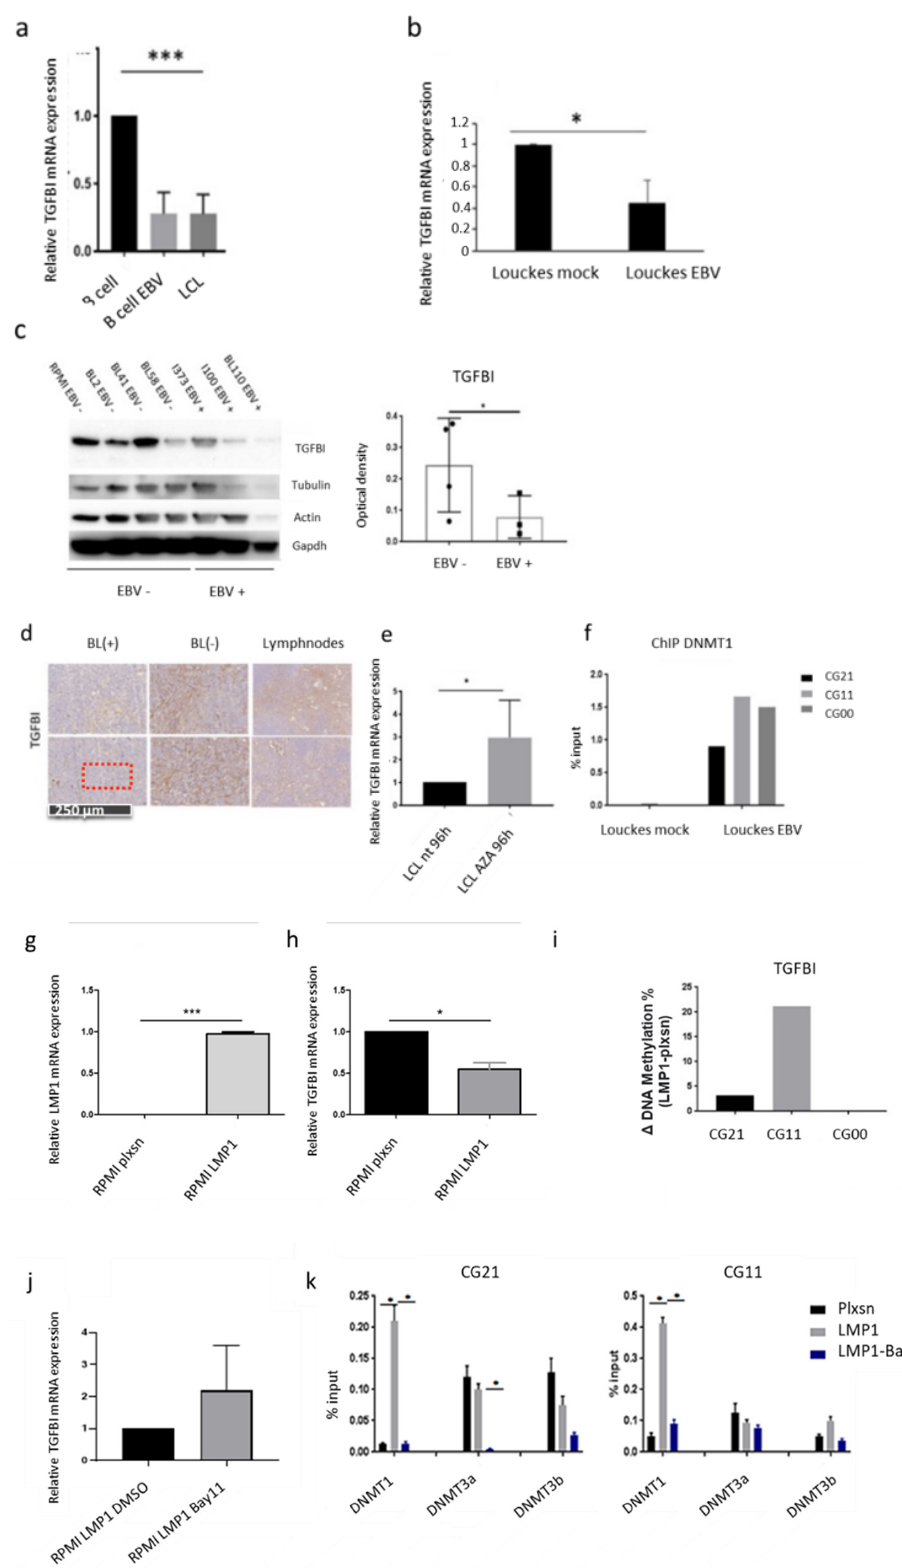
Figure 3. EBV infection leads to TGFBI silencing. ( a ) qPCR analysis of TGFBI mRNA expression levels in primary B cells from 3 independent donors infected with EBV and collected at t = 0 h (B cell), t = 48 h (B cells EBV), and t = 4 weeks (LCL), (* p < 0.05; *** p < 0.001) ( b ) qPCR quantification of TGFBI mRNA expression in Louckes cells (EBV (-)) vs. Louckes-EBV. ( c ) Western blot analysis of TGFBI protein expression in several EBV(-) and EBV(+) BL cell lines. The histogram shows the average TGFBI protein levels normalized to the ß-actin, tubulin, and GAPDH signals, measured by Image Lab software (Bio-Rad) in EBV(-) versus EBV(+) BL cells. ( d ) Immunohistochemistry analysis of TGFBI levels in EBV(+), EBV(-) BL, and lymph nodes samples. ( e ) qPCR quantification of TGFBI mRNA in LCL cells treated with the demethylating agent 5-aza-2-deoxycytidine (LCL Aza) or DMSO (n = 3). ( f ) Chromatin Immunoprecipitation (ChIP-qPCR) assessing DNMT1 recruitment on the three CpGs of interest in Louckes vs. Louckes-EBV cells. ( g , h ) qPCR analysis of LMP1 and TGFBI expression levels in RPMI cells retrotransduced with an LMP1-encoding vector (pLXSN-LMP1) or pLXSN. n = 3 ( i ) pyrosequencing quantification of TGFBI methylation within the CpGs CG21, CG11, and CG00 in RPMI-LMP1 and RPMI-pLXSN (n = 2). ( j ) qPCR analysis of TGFBI mRNA levels in RPMI-LMP1 cells treated for 2 h with BAY11-7082 (Bay11) (10 µM) (n = 3). ( k ) ChIP-qPCR quantification of DNMT1, DNMT3a, and DNMT3b enzymes recruitment on CG21 and CG11 sites in RPMI-LMP1 or RPMI-pLXSN (n = 3). 3.4. AFB1 Enhances the EBV-Induced TGFBI Downregulation Because our results revealed the differential methylation shared by the two eBL risk factors (EBV and AFB1) (Figure 1), we next investigated the combined effect of EBV infection and AFB1 exposure in deregulating TGFBI. To recapitulate the presumed natural order of exposure to the two risk factors in subequatorial African countries, where AFB1 exposure starts in utero, and EBV infection occurs in early postnatal life, we treated primary B lymphocytes from three different healthy donors with AFB1 in vitro for 24 h prior to EBV infection [52,53]. Cells were subsequently maintained in culture until immortalization (LCL cell lines) (Figure 4a). The derived immortalized LCL cells were then subjected to RT-qPCR to evaluate TGFBI mRNA expression levels as well as the expression of the viral genes LMP1 and BLZF1 (to assess the infection status in the presence of AFB1). Both the levels of LMP1, a latency gene encoding for the major viral oncoprotein, and BZLF1, a key regulator of latent-to-lytic cycle transition and expressed in the prelatency state following de novo infection, increased after AFB1 treatment. This result was expected, as previously reported, that AFB1 enhances EBV infection potential and transforming ability [33] and provided reliable evidence for the observed TGFBI downregulation. Here, the pretreatment with AFB1 led to a significant decrease of TGFBI